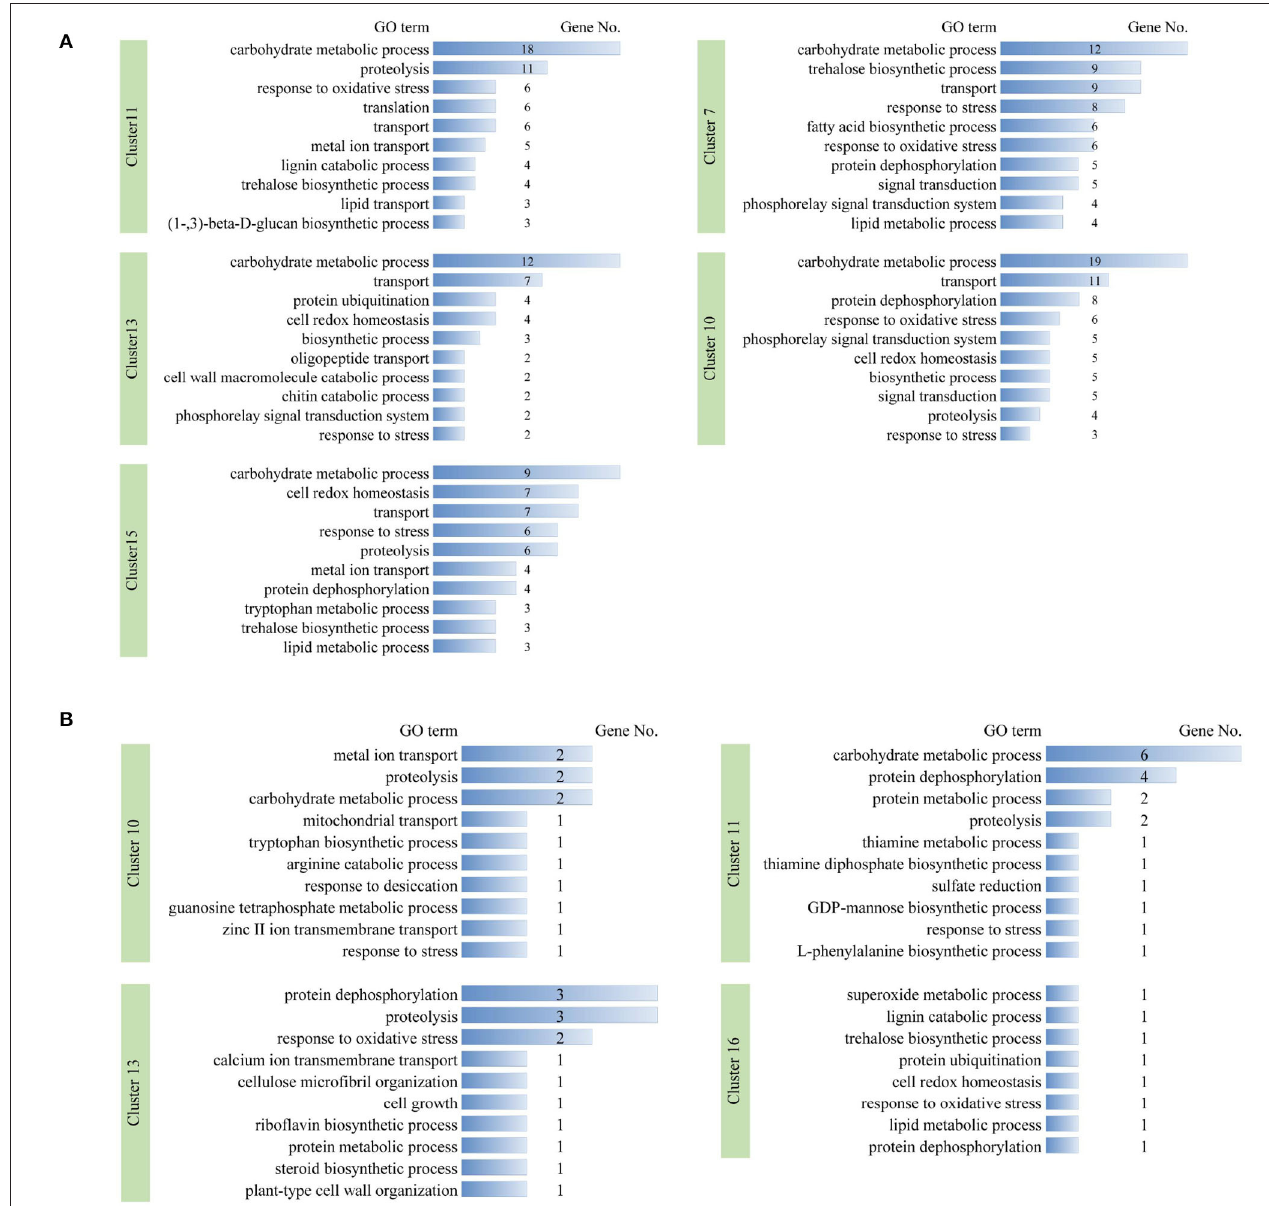
FIGURE 5 | Gene ontology terms with predominant numbers of DEGs in stress-responsive timer-series clusters under dehydration (A) and cold (B) stresses, respectively. DEG number in each GO term is shown.